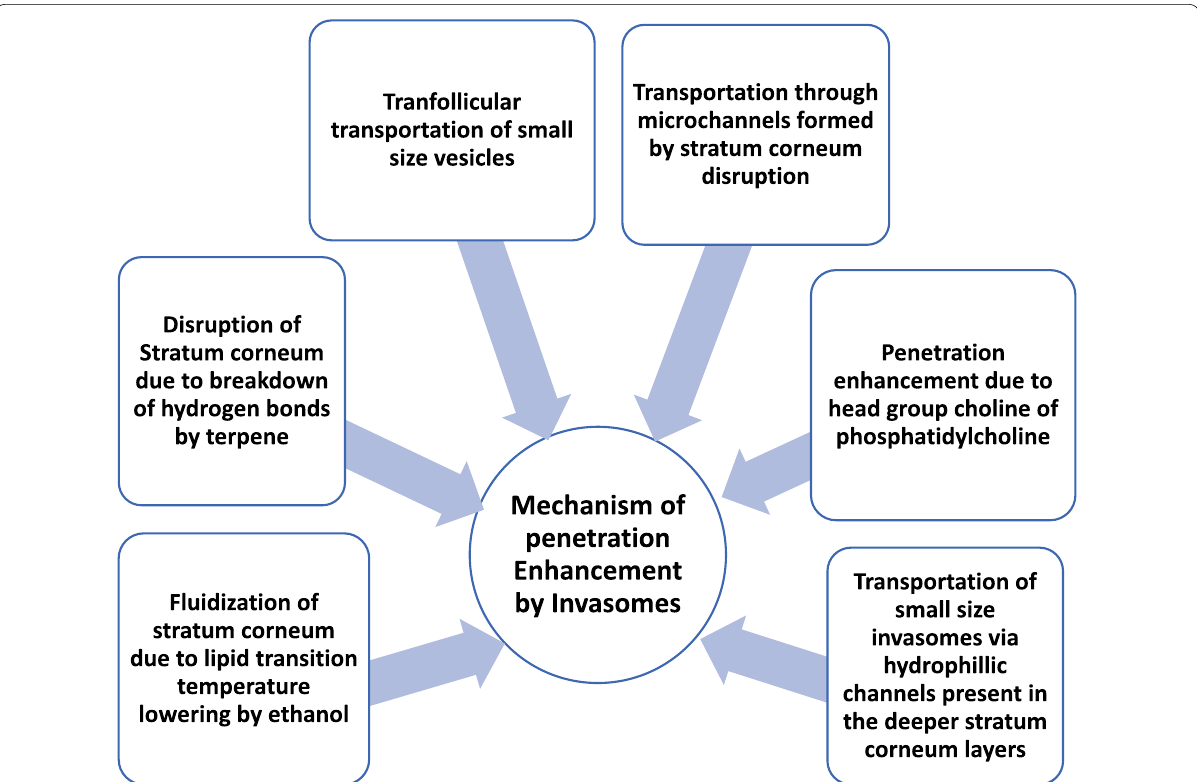
Fig. 2 Mechanism of penetration enhancement by